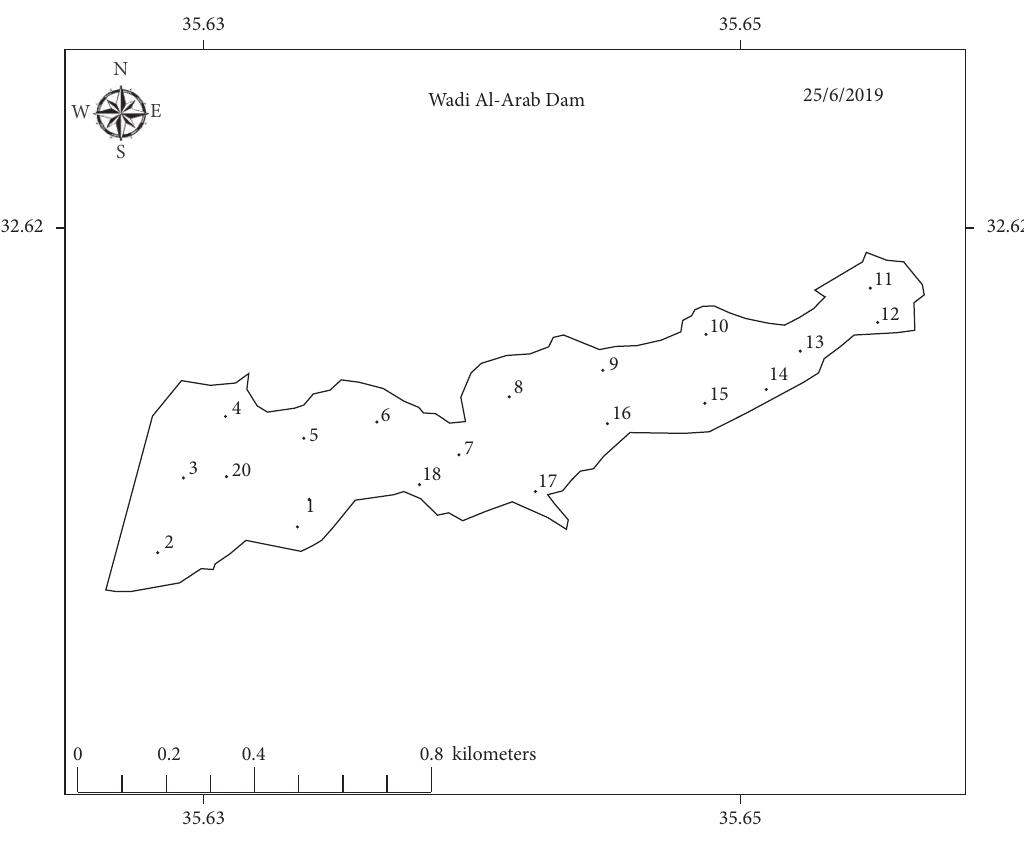
Figure 4: Sampling points distribution of Wadi Al-Arab